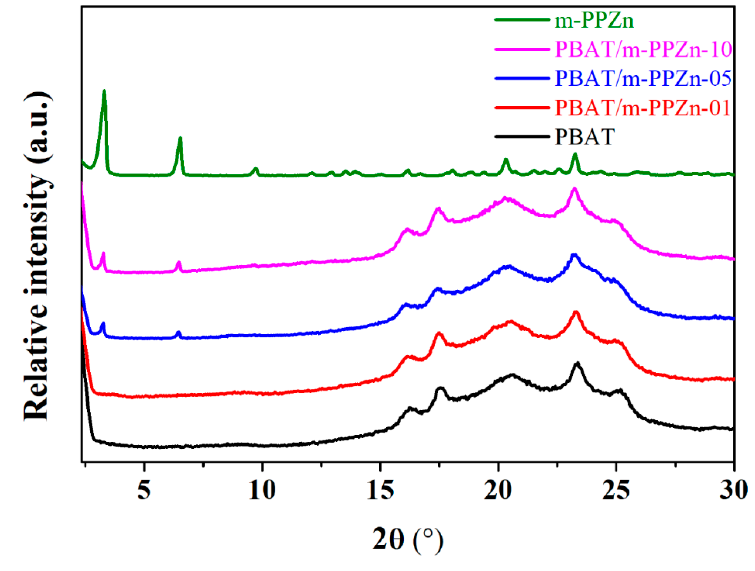
Figure 3. WAXD results of m-PPZn, PBAT, and PBAT/m-PPZn composites.